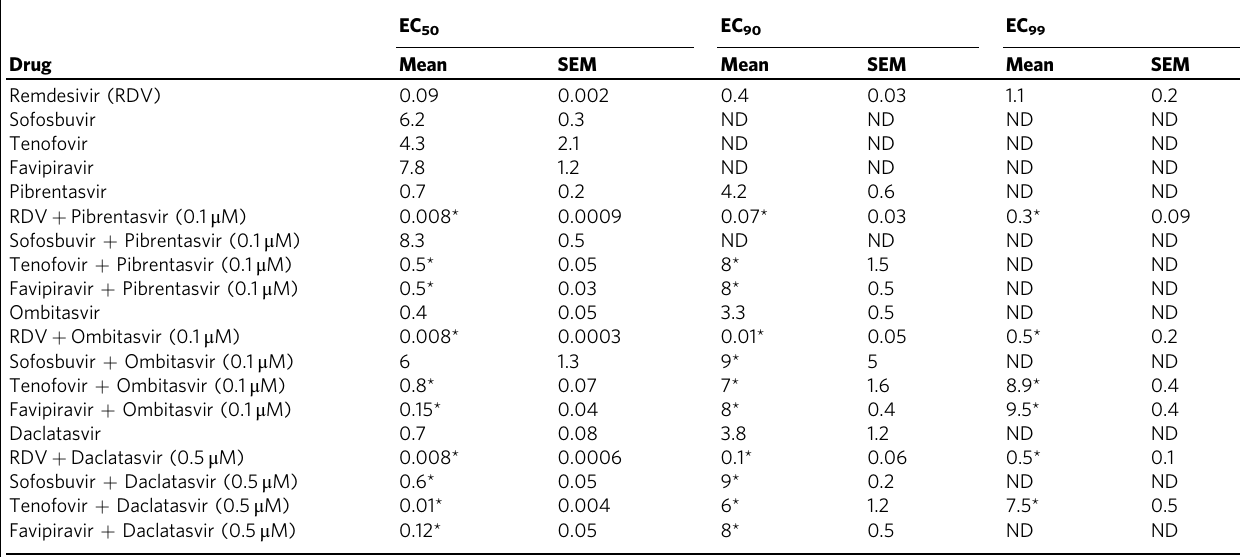
Table 1 In vitro pharmacological parameters of potency and ef fi cacy of combinations of RdRp and HCV NS5A inhibitors on SARS- CoV-2 replication in Calu-3 cells.